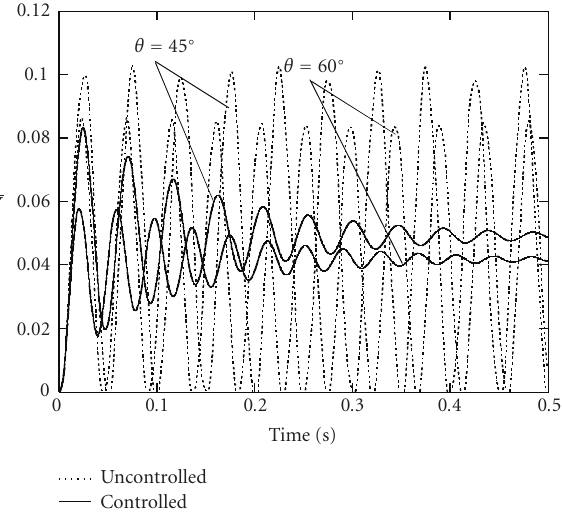
Figure 14: Variation of the second coupled open/closed flapping- lagging frequency versus ply angle for selected rotating speeds with the piezoelectrically induced bending moments ( K y = K x = 0 . 025, γ = β = 0).